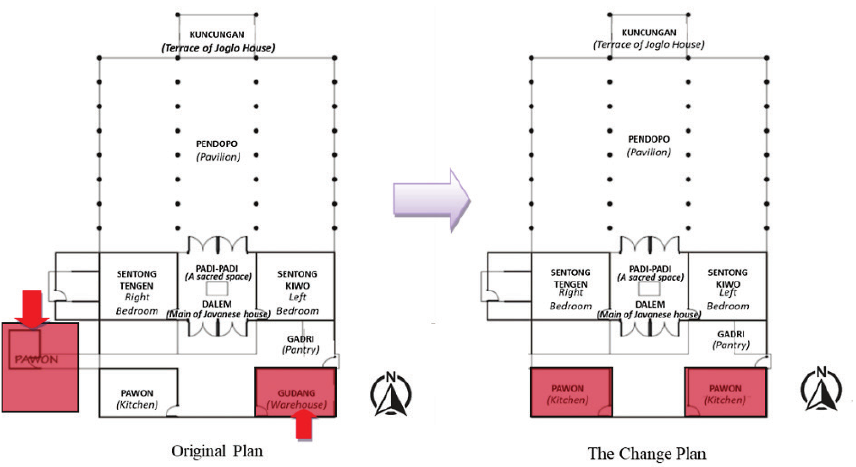
Figure 3. The change plan in Kasepuhan house at Kadilangu (source: Survey, 2017)